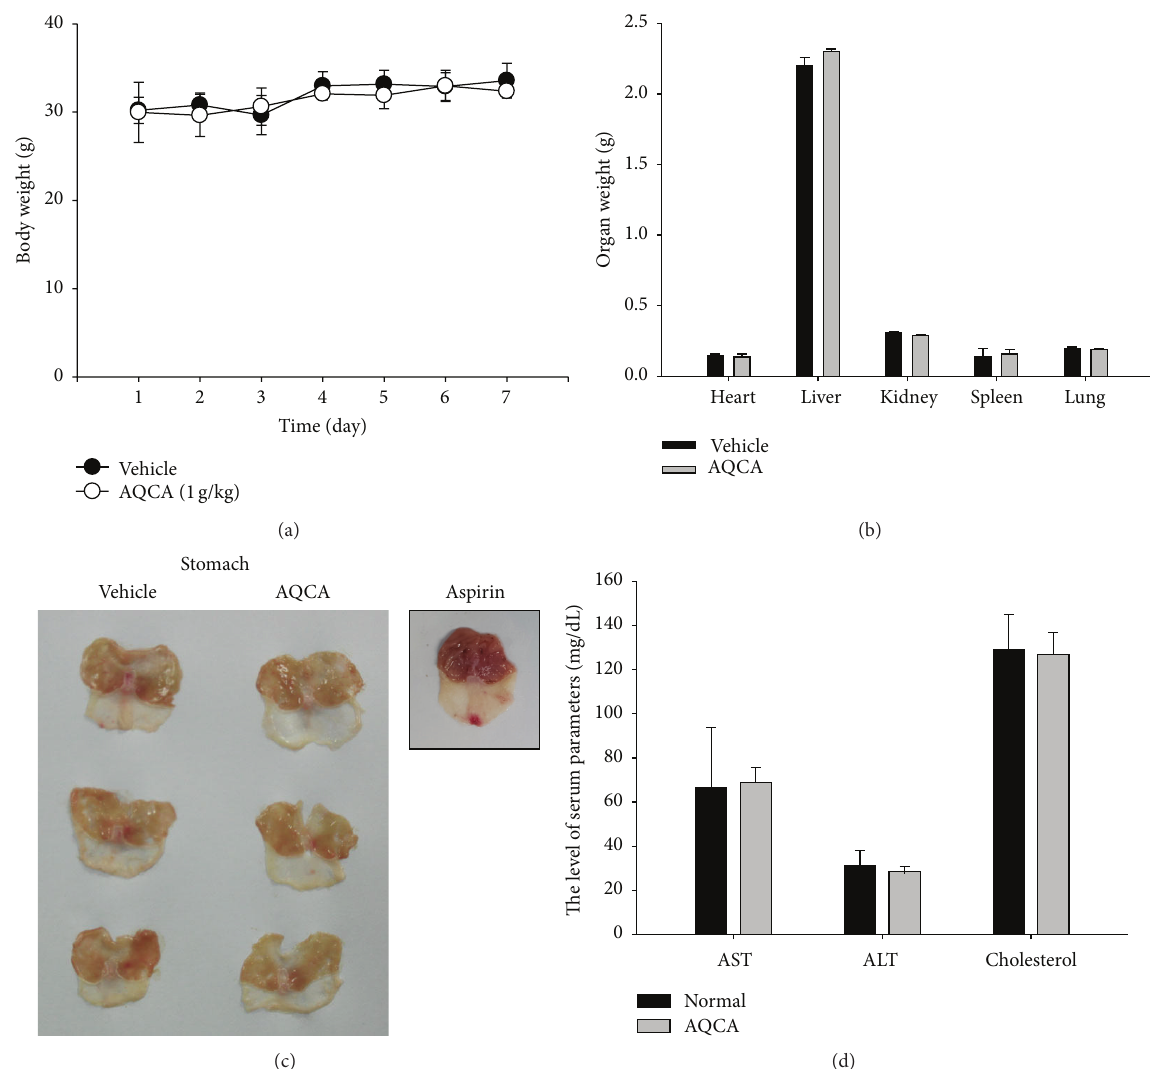
Figure 3: Acute toxicity of AQCA in mice. (a and b) Changes in total body weight or organ weight were evaluated following oral administration of AQCA for 7 days. (c) Formation of stomach lesions following oral administration of AQCA (1g/kg) or aspirin (300 mg/kg) for 7 days. (d) Acute toxicity of oral administration of AQCA for 7 days was evaluated by measuring serum parameters (AST, ALT, and cholesterol). Data represent the mean ± SD of an experiment performed with three